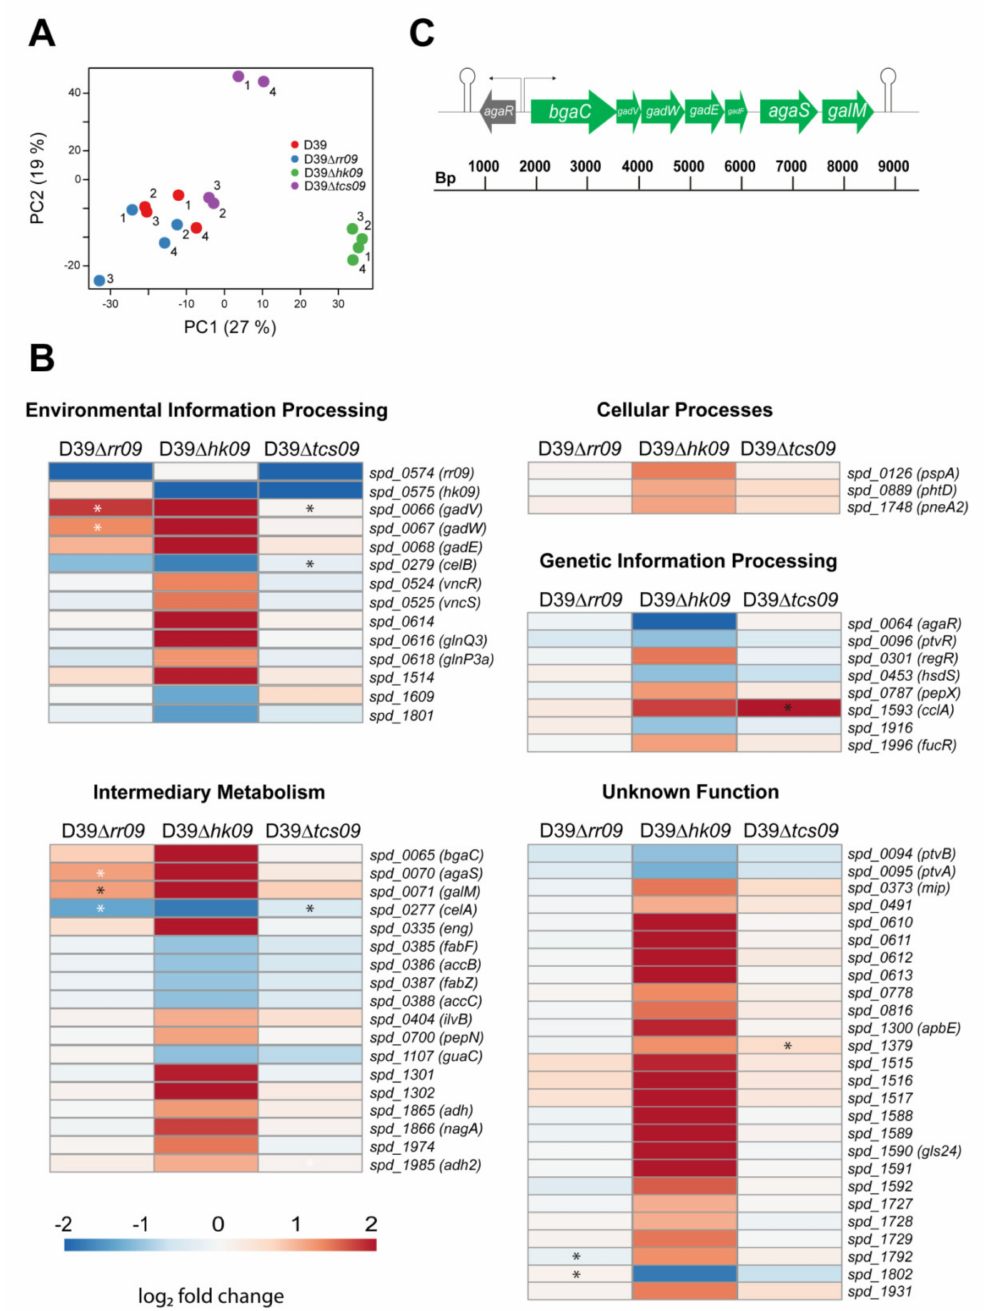
Figure 2. Expression profile of two-component regulatory system 09 mutants. ( A ) Principal component analysis (PCA) of all S. pneumoniae samples with color codes. ( B ) Heat maps showing genes with altered expression compared to the wild-type strain D39. Red boxes show upregulation and blue boxes show downregulation in gene expression. The heat maps are divided into different functional categories. The boxes represent the average log 2 fold change values of four replicates of each strain. A black asterisk (*) means that the coefficient of variation (CV) values of the corresponding gene in the strain replicates is > 1.5 x interquartile range (IQR). White stars indicate a significantly different expression pattern. All presented genes in D39 ∆ hk09 are significantly changed. Heat maps showing the log 2 fold changes in individual replicates of D39 ∆ rr09 , D39 ∆ hk09 , and D39 ∆ tcs09 are depicted in Figure S5. ( C ) Genomic organization of the aga operon in S. pneumoniae D39. Genes within the aga operon are shown in green, and the gene encoding AgaR is upstream of the aga operon and shown in grey. The large and filled arrows represent their relative gene size and orientation in the genome. Transcriptional start sites are indicated with thin arrows and terminators with lollypops. Schematic representation was designed according to information from the Pneumobrowser (https://veeninglab.com/pneumobrowse visited on 19 September